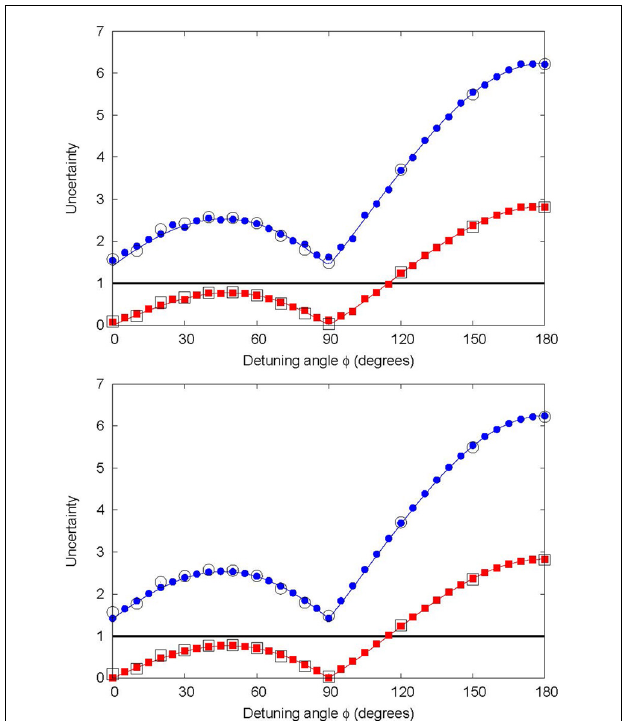
FIGURE 5 | Uncertainties (cid:3) ( A ) η ( B ) + (cid:3) ( A ) σ ( B ) + σ ( A ) η ( B ) (circles) and (cid:3) ( A ) η ( B ) (squares) as obtained from the event-by-event simulations (solid symbols) of the single-neutron experiment [14, 15], the experiment itself ((open symbols), data kindly provided to us by G. Sulyok and Y. Hasagawa) and quantum theory. The solid horizontal line represents the lowerbound in Equation (24). The other solid lines represent the corresponding quantum theoretical prediction as obtained from Equation (35). It is clear that the naive application of the Heisenberg uncertainty relation, (cid:13) ( A ) η ( B ) ≥ 1 is at odds with the prediction of quantum theory, the event-based simulation data and with the experimental data [14, 15]. On the other hand, the experimental data (open symbols, 14, 15) and the results of the event-based simulation (solid symbols) comply with inequality Equation (24). Top: Simulation performed using the probabilistic model for the spin analyzer, see Equation (18). Bottom: Simulation performed using the deterministic learning machine model for the spin analyzer, see Equation (19), with γ = 0 . 999. In both cases, the number of input events per detuning angle is N = 10000.